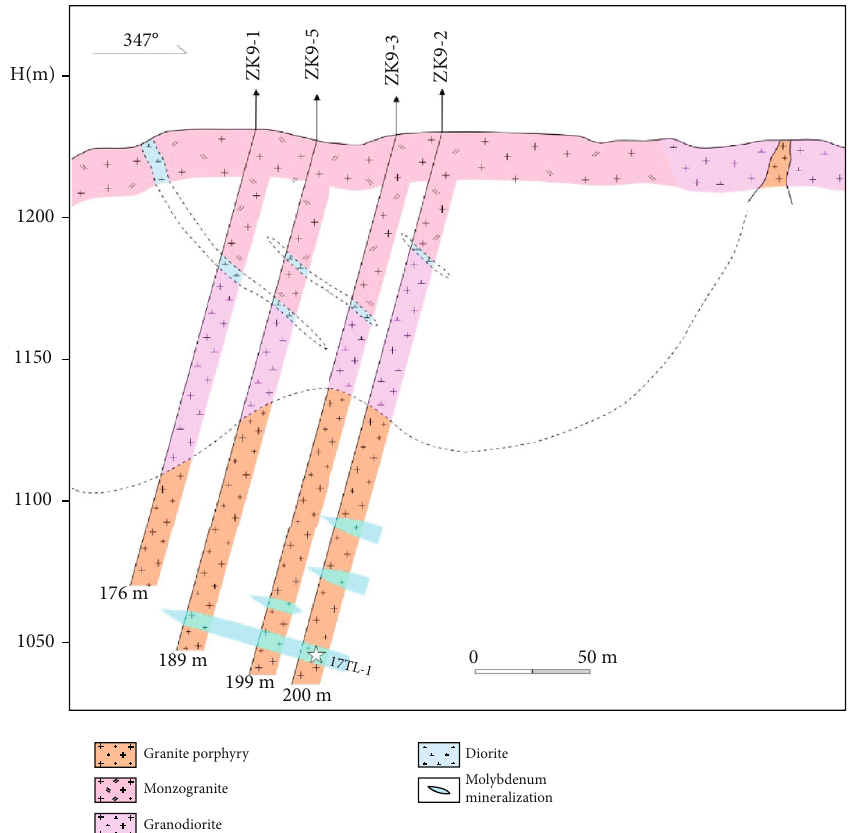
Figure 3: The geological section along the no. 9 exploration line on the map with lithologies and